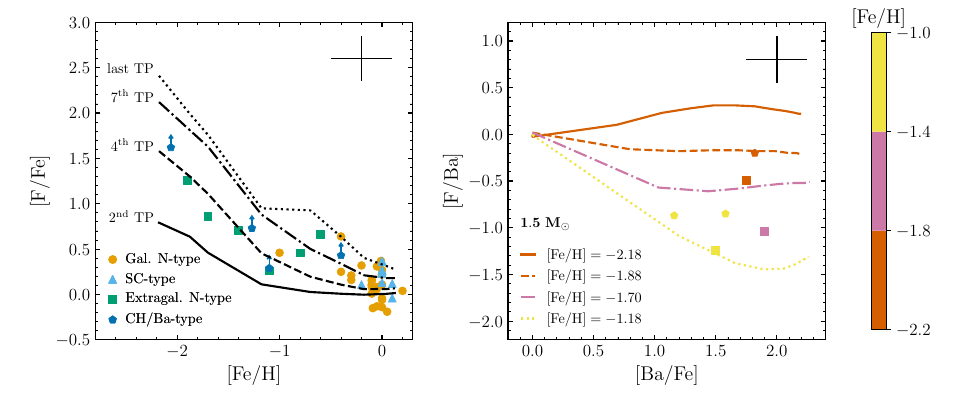
Figure 3. (Left panel) Comparison between observed [F / Fe] ratios as a function of the metallicity and FRUITY Magnetic models. Symbols refer to four data groups: circles, galactic (N-type) carbon stars; triangles, SC-type stars; squares, extragalactic carbon stars; pentagons, extrinsic CH / Ba stars. Lines represent theoretical predictions for 2 (for [Fe / H] ≥ − 0 . 7) and 1.5 M ⊙ (for [Fe / H] < − 0 . 7) AGB stars at di ff erent thermal pulses (TPs). (Right panel) [F / Ba] vs. [Ba / Fe] in the sample stars with [Fe / H] ≤ − 1 . 0. Data points and theoretical lines are color-coded by [Fe / H]. Typical error bars are